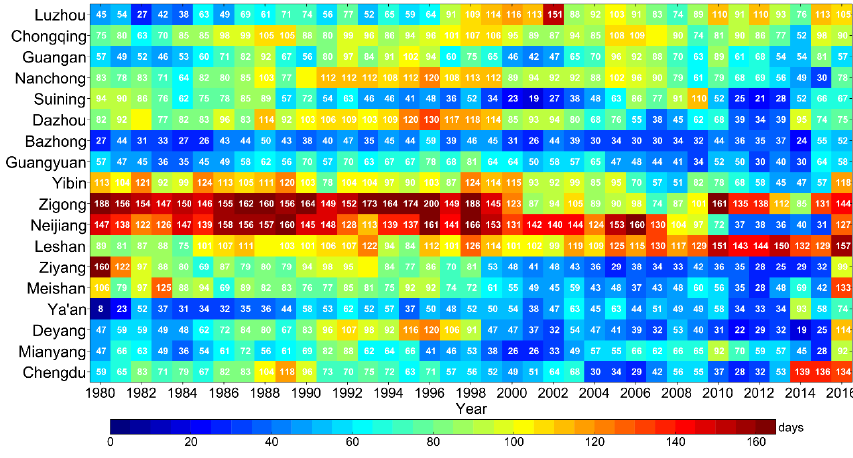
Figure 5. The annual variations of HDs in 18 main cities of SCB from 1980 to 2016. The multi-year monthly mean HDs at all sites in SCB and those in the rest of SCC are shown in Figure 6a,b. For all sites in SCB, the maximum seasonal mean HDs were found in winter (December to February), with the monthly mean HDs of 12.9, 9.0, and 12.8 days for January, February, and December, respectively, while the minimum HDs were found in summer, with the monthly mean HDs of 2.2, 1.6, and 1.7 days for June, July, and August, respectively. A similar pattern is found for all sites in the rest of SCC, with a much smaller number of expected HDs. In addition, Figure 6c also presents the multi-year (1980–2016) monthly variation in HDs in 18 main cities. Overall, the